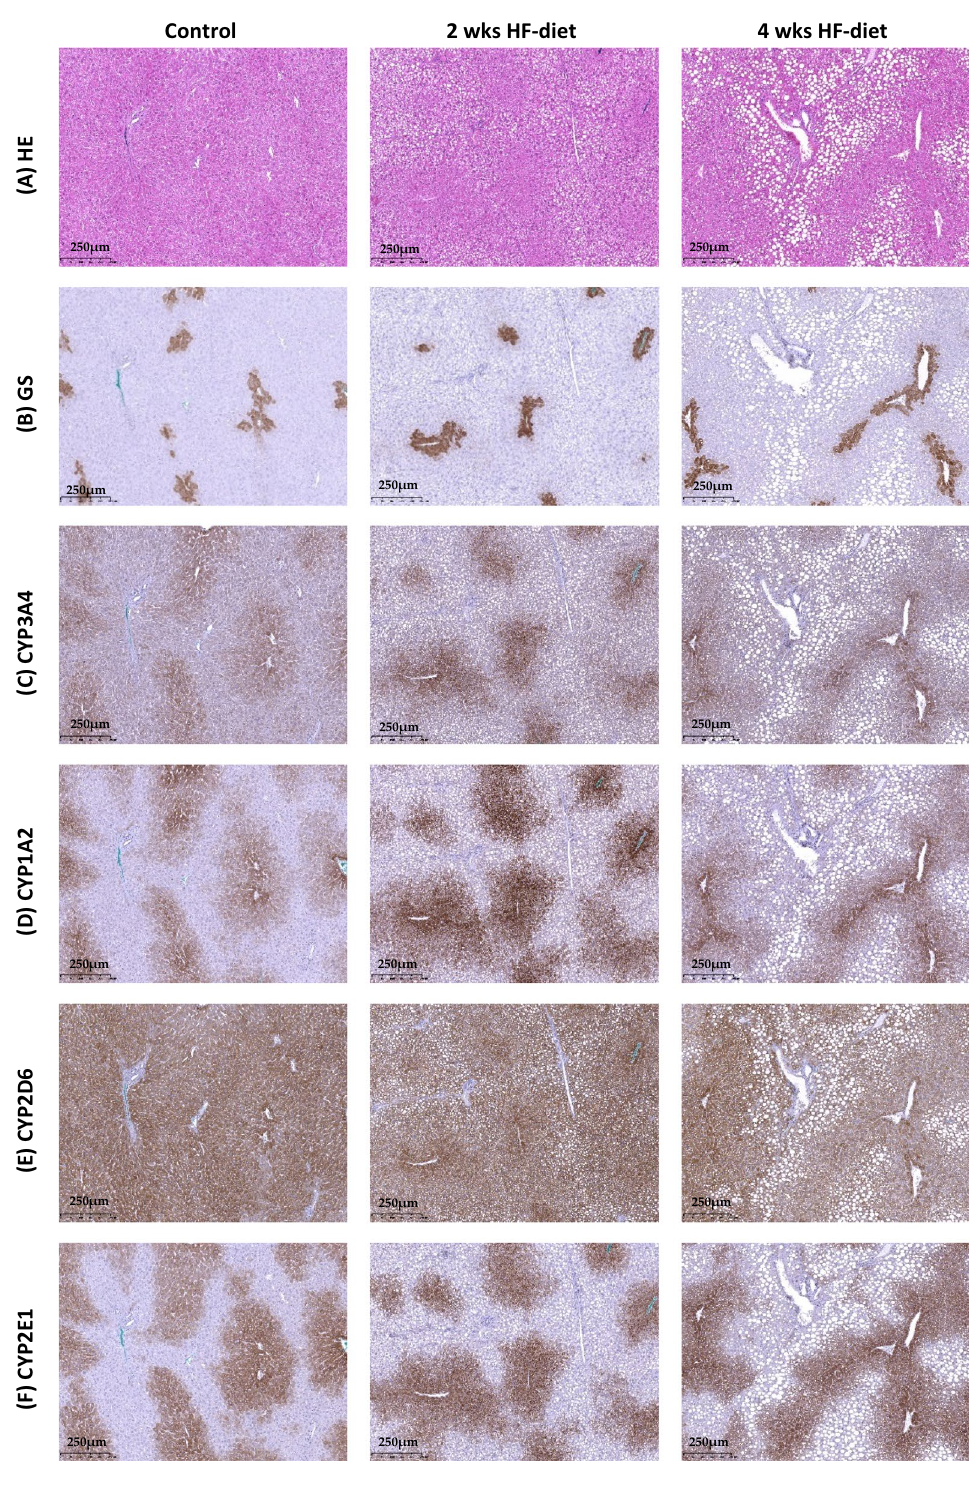
Figure 2. Visualization of steatosis and CYP expression in normal and experimental animals subjected to two weeks respectively four weeks of HF-diet. ( A ) HE-staining shows periportal steatosis with predominantly microvesicular pattern after two weeks of feeding and predominantly macrovesicular pattern after four weeks of feeding; ( B ) Glutamine synthetase (GS)-staining for annotation of pericentral hepatocytes around the central vein, and discrimination of periportal from pericentral zones; ( C ) CYP3A4 staining present in pericentral location without substantial differences in the distribution of positive signals between the three groups; ( D ) CYP2D6 staining also present in pericentral location without substantial differences in the distribution of positive signals between the three groups; ( E ) CYP2D6 expressed almost in the whole lobules with 1–2 lines of dark brown stained hepatocytes around the central vein with similar pattern in all three groups; ( F ) CYP2E1 expression slightly different compared to CYP3A4 with 4–5 lines of hepatocytes presenting signals of strong intensity around the central vein, also with no differences between groups; Scale bar 250